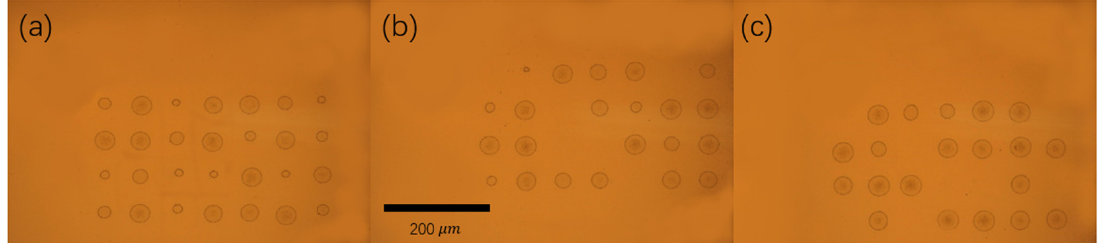
Figure 5. The results of the ablation experiments when the double-pulse delay time was 0 ps: ( a )—energy ratio of 1:9; ( b )—energy ratio of 2:8; ( c )—energy ratio of 5:5. Panels ( a – c ) have the same scale. The scale bar is 200 μ m.